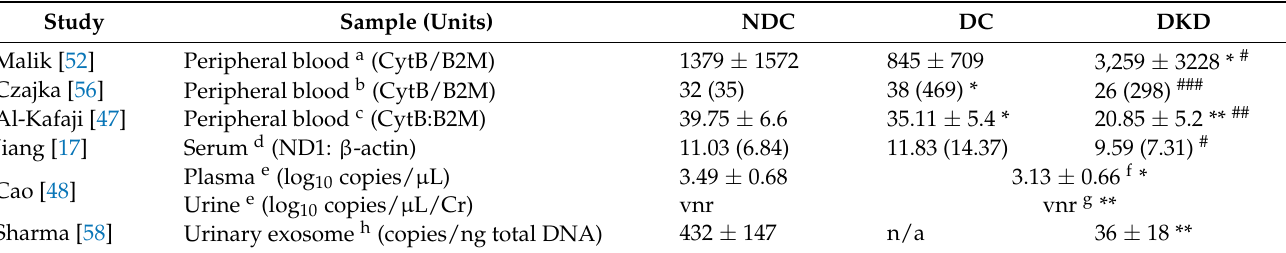
Table 2. Summary of mtDNA